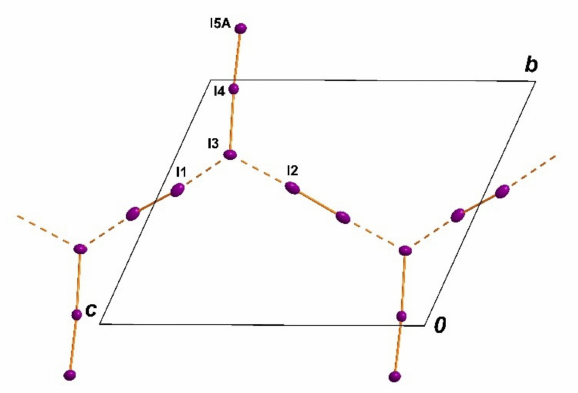
Figure 4. [Cu(12-crown-4) 5 (H 2 O) 6 ]I 6 · 2I 2 . All shown atoms are drawn with a 50% probability of the displacement ellipsoids. The branched chain is located parallel to the bc plane running along the c